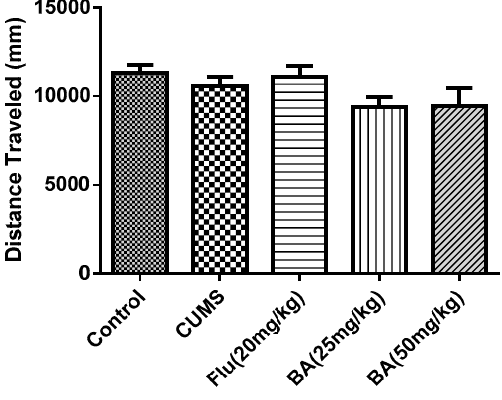
Figure 3. Effects of BA in the open field test (OFT). Data were expressed as mean ± SEM ( n = 12).